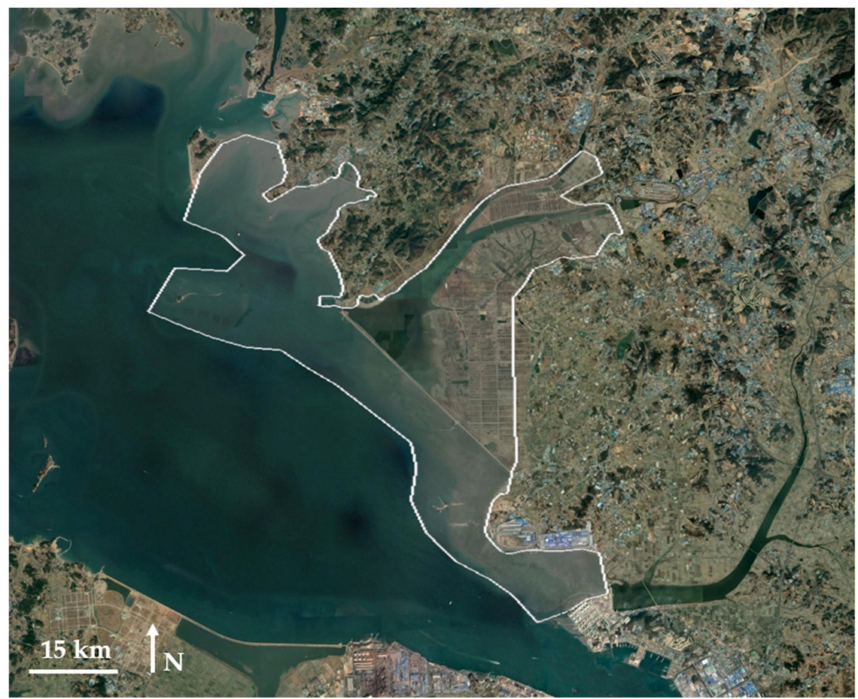
Figure 8. The white polygon indicates the optimal boundaries for a Ramsar site or World Heritage site in the Hwaseong Wetlands, based on our research, on existing infrastructure, and on guidance provided by the texts of the Ramsar Convention, and in World Heritage guidelines (Map data ©2021 Google, Mountain View,